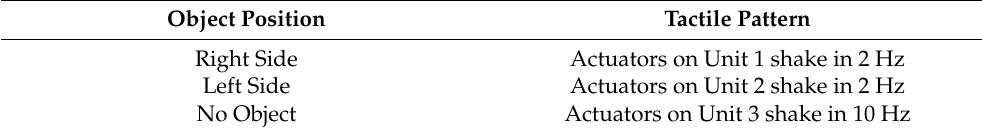
Table 5. Relationships between a detected object and a tactile pattern using tactile display 2.